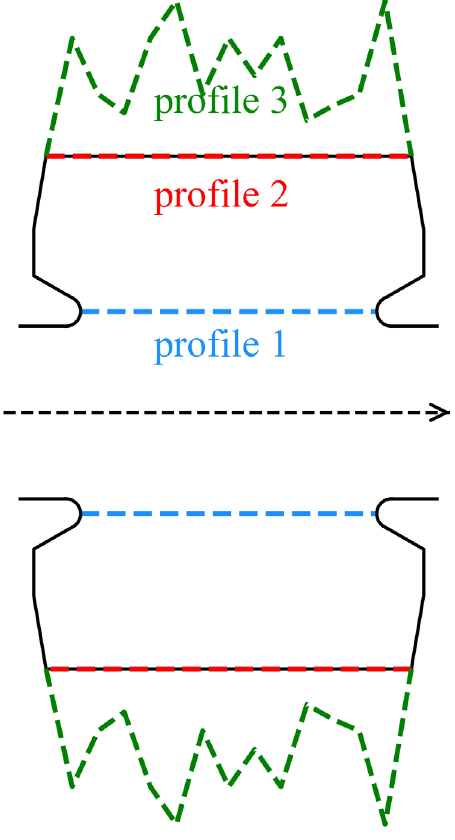
FIG. 3. Three equivalent geometries with different outer wall boundaries, which result in the same short-range wake up to some distance s . Profile 1 corresponds to a shallow cavity with the max 27 mm. Profiles 2 corresponds to the original cavity radius r max ¼ 68 . 4 mm. Profile 3 represents a cavity with of Fig. 1 with r max ¼ s Þ > 68 . 4 mm. an arbitrary outer wall variation, and r max ð